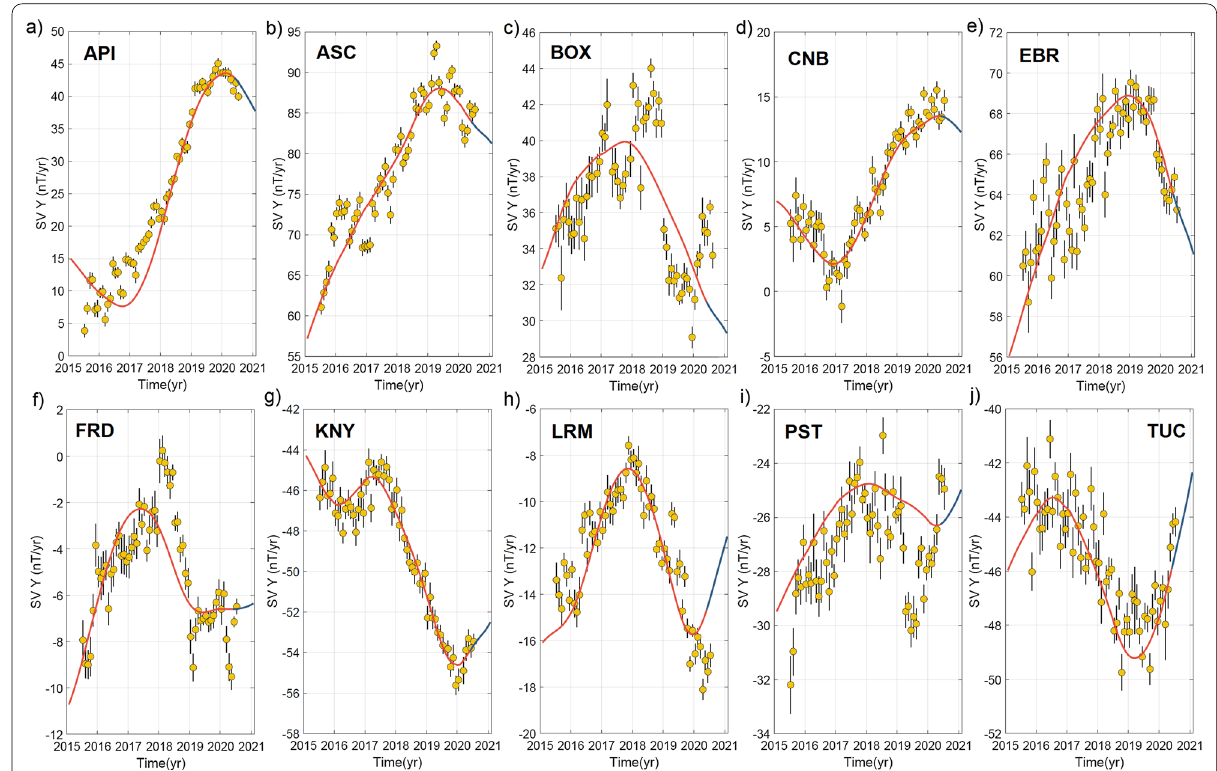
Fig. 1 Secular variation (SV) of the East component Y at different observatory locations. Yellow dots represent the SV (with its error bars) computed from the monthly mean observatory data. See the locations of the selected observatories in Fig. 3. Red and blue curves are the SV estimation at the respective location given by the CHAOS‑7.7 model (Finlay et al. 2020). Note that after August 2020 the changes in the curves (blue lines) from CHAOS‑7.7 are likely affected by the model regularization instead of the data (see Sect. 3 for more